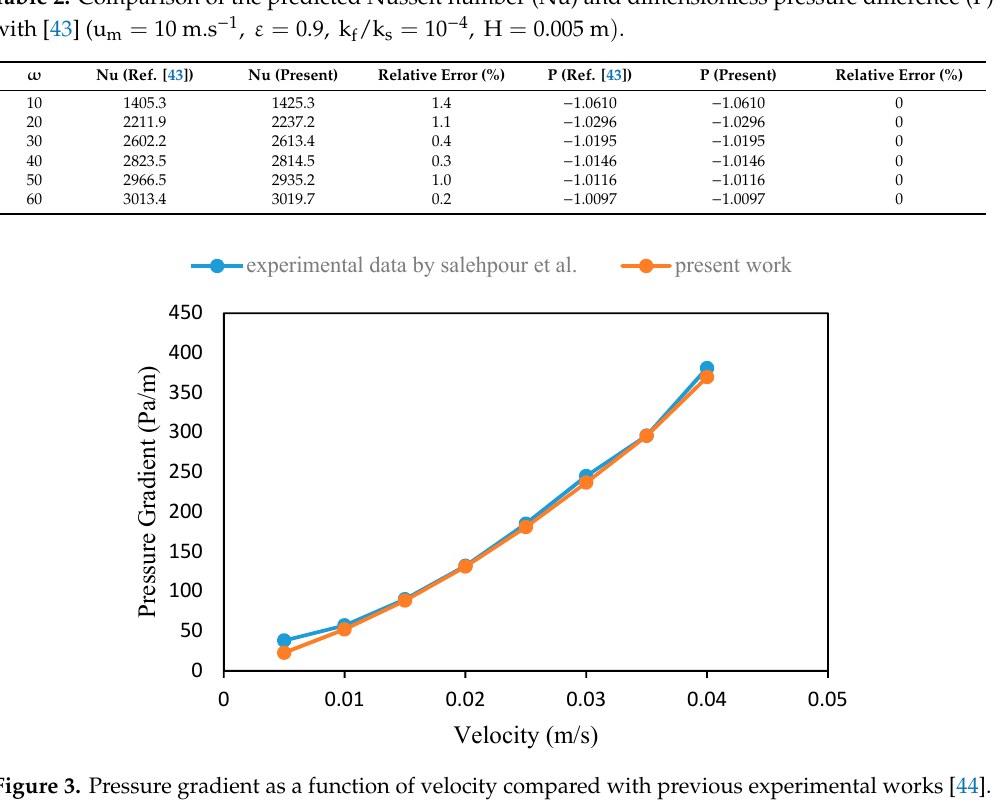
Table 3. Input parameters used in the numerical simulation.